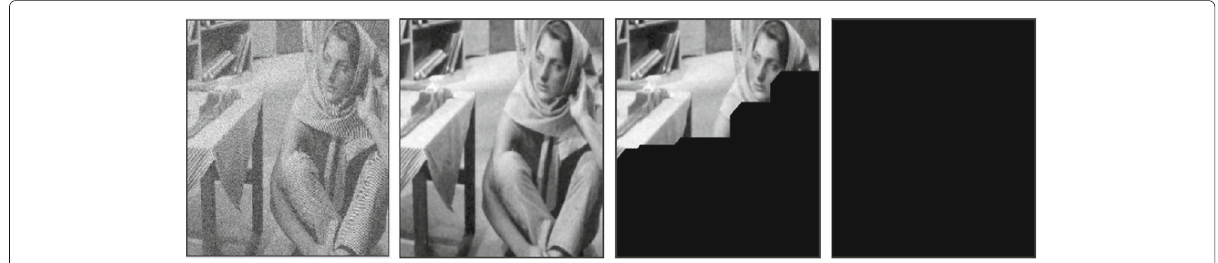
Fig. 6 Lefttoright: noisy Barbara image, restored image by PMPL with p = 12.5,16.5, and 18.5, respectively